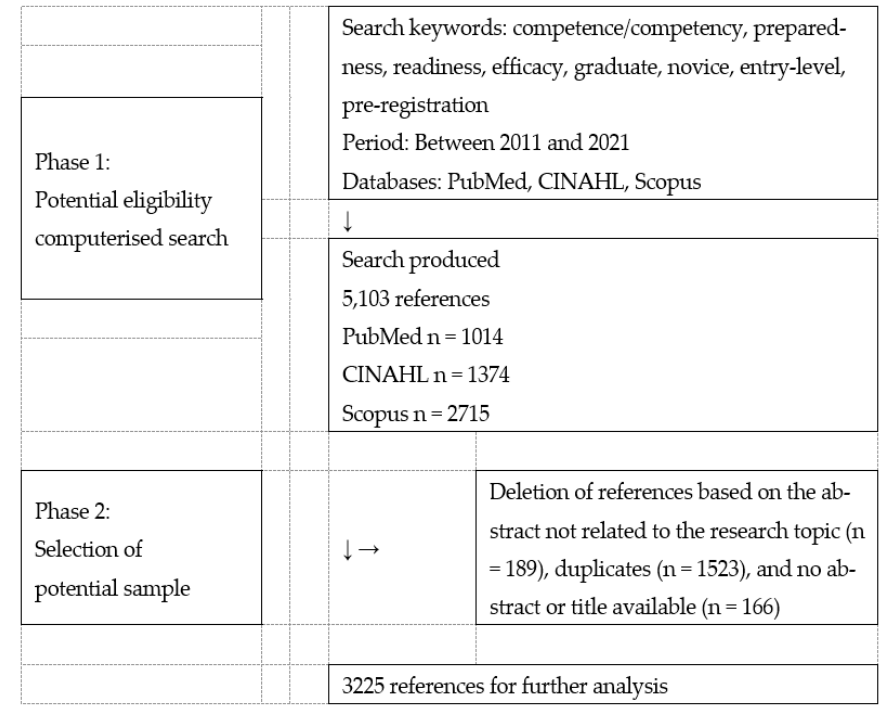
Figure 1. Literature search